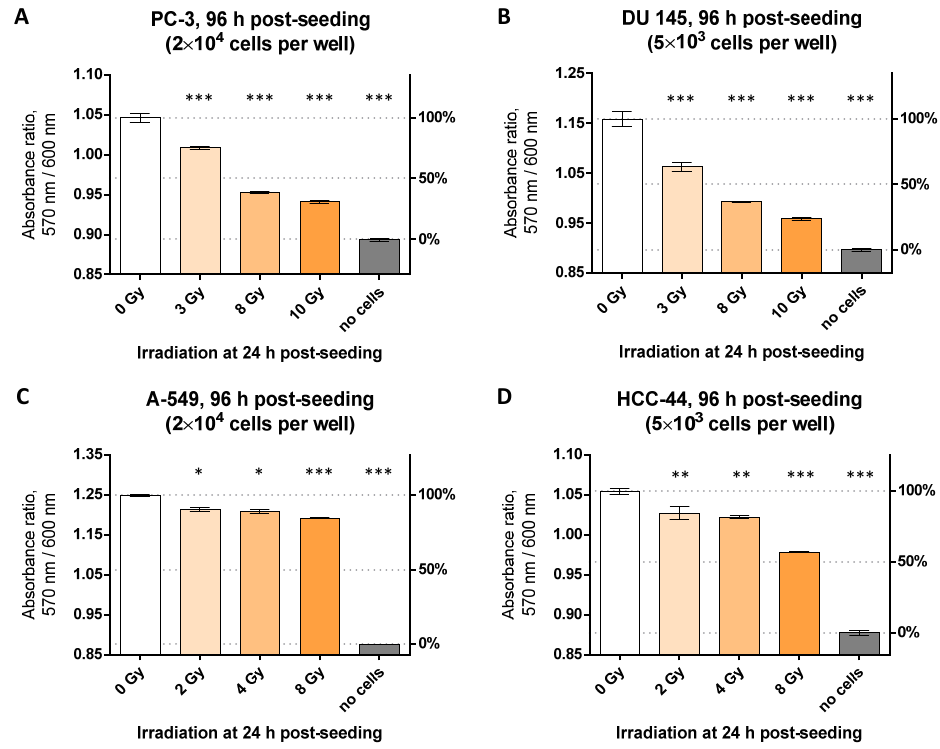
Figure 5. Resazurin assay following irradiation studies using different doses in various cell lines (12-well format). Irradiation of cells was carried out at 24 h post-seeding and measurement of viability was performed at 96 h post-seeding. Each graph presents pooled data (mean ± SEM) from 2 or more independent experiments. On the left Y-scale, the detected optical characteristic is shown (absorbance ratio, 570 nm/600 nm); on the right Y-scale, normalization of the pooled data is presented for easier interpretation (non-irradiated well with cells: 100% viability; non-irradiated well without cells: 0% viability). Measurements were carried out at 50 μ M resazurin. ( A ) PC-3 cell line, incubation time with resazurin: 75 min; ( B ) DU 145 cell line, incubation time with resazurin: 60 min; ( C ) HCC-44 cell line; and ( D ) A-549 cell line, incubation time with resazurin: 90 min. The statistical significance of difference between the irradiated and non-irradiated wells was assessed using 1-way ANOVA with Dunnett’s test for multiple comparisons; *** indicates p ≤ 0.001, ** indicates p ≤ 0.01, * indicates p ≤ 0.05.